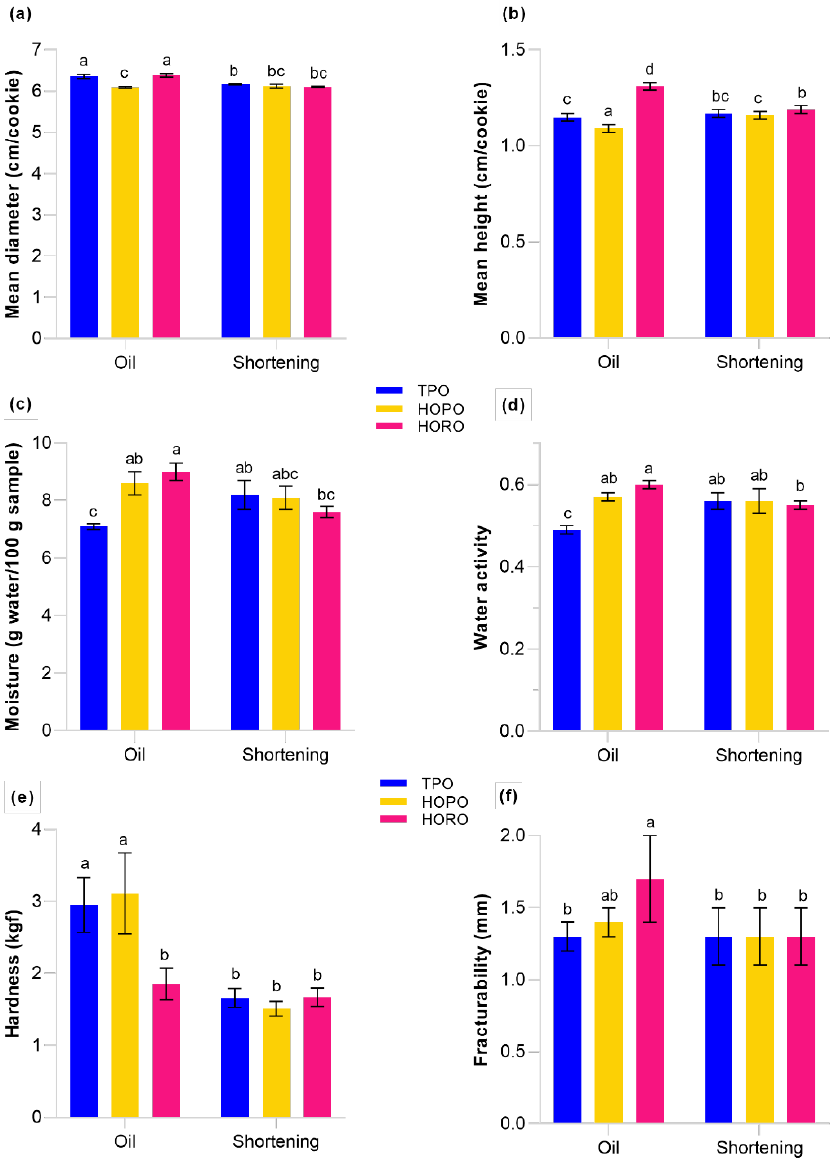
Figure 5. Physical properties of cookies made with oil and shortenings. Different letters above the bars indicate statistically significant difference at p ≤ 0.05 (one-way ANOVA). ( a , b ) Mean diameter and height: A standard deviation of 0.02 cm represents the smallest measurement that could be reliably taken per cookie. n = 2 for all measurements; ( c , d ) Moisture and water activity: n = 3 for all measurements; ( e , f ) Hardness and fracturability: n = 8 for all